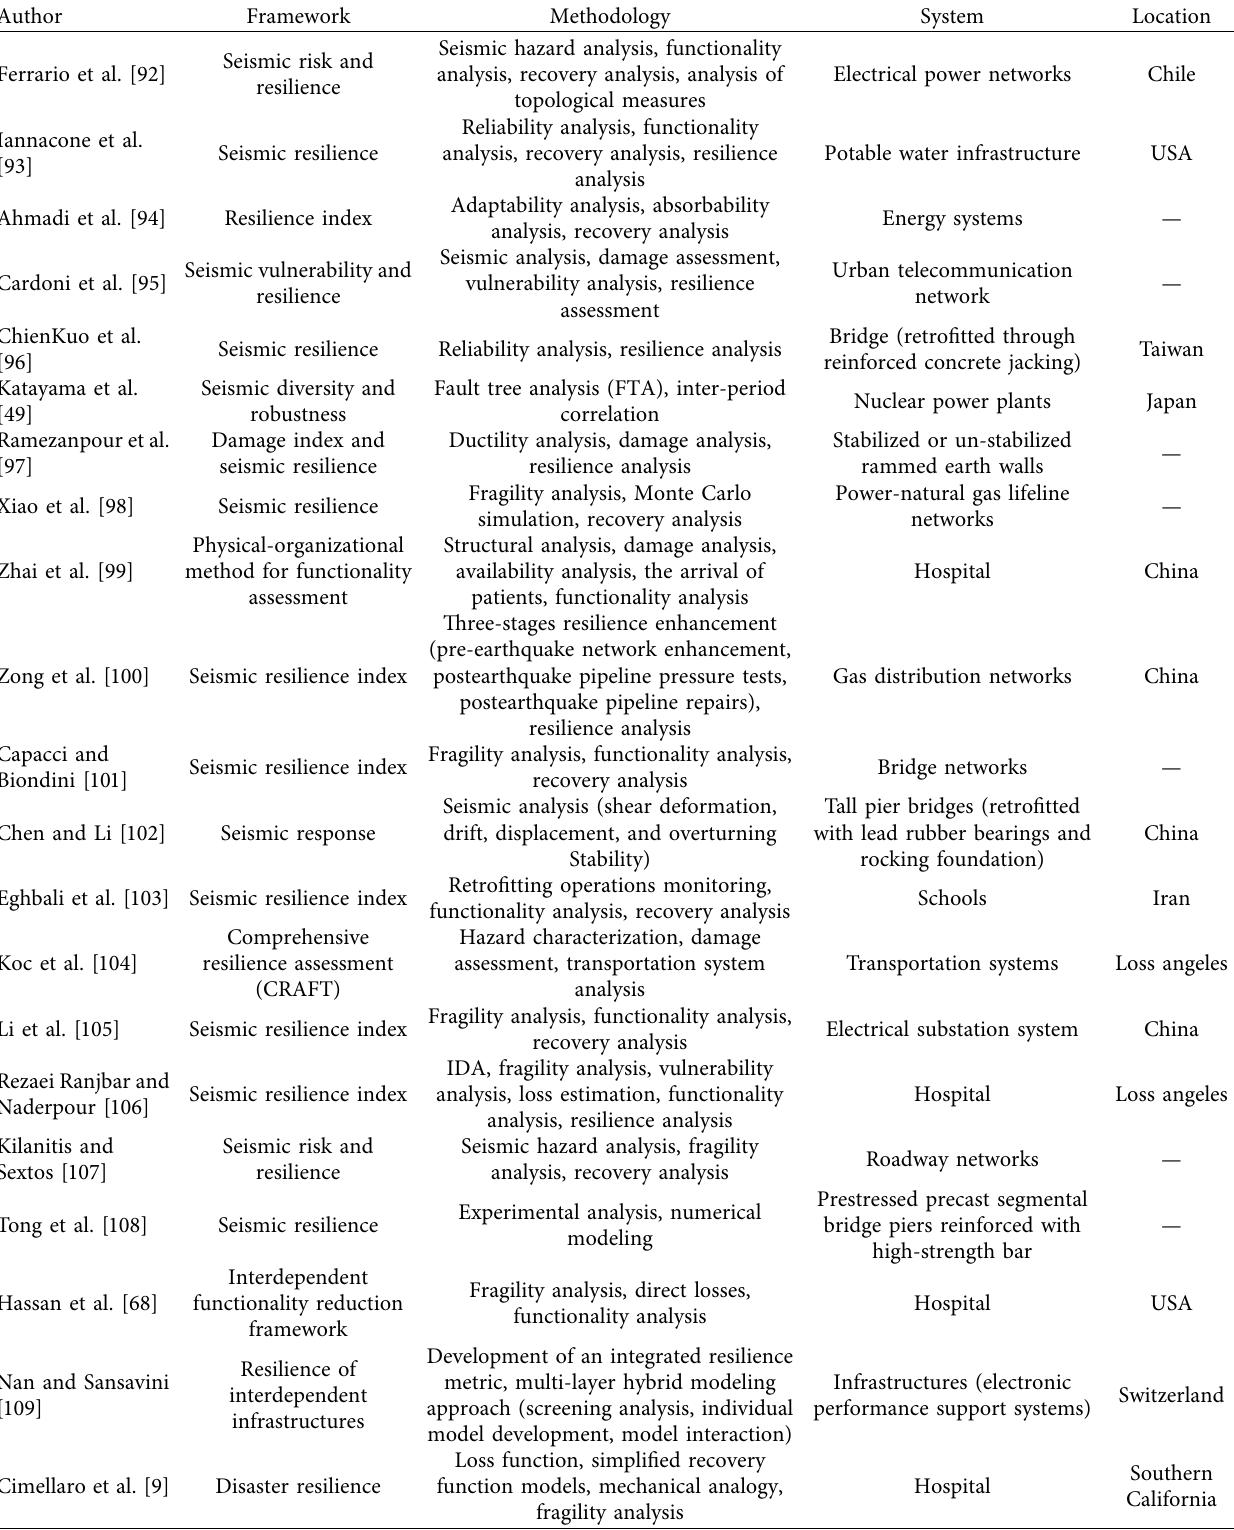
Table 6: Seismic resilience frameworks for sub-systems of the